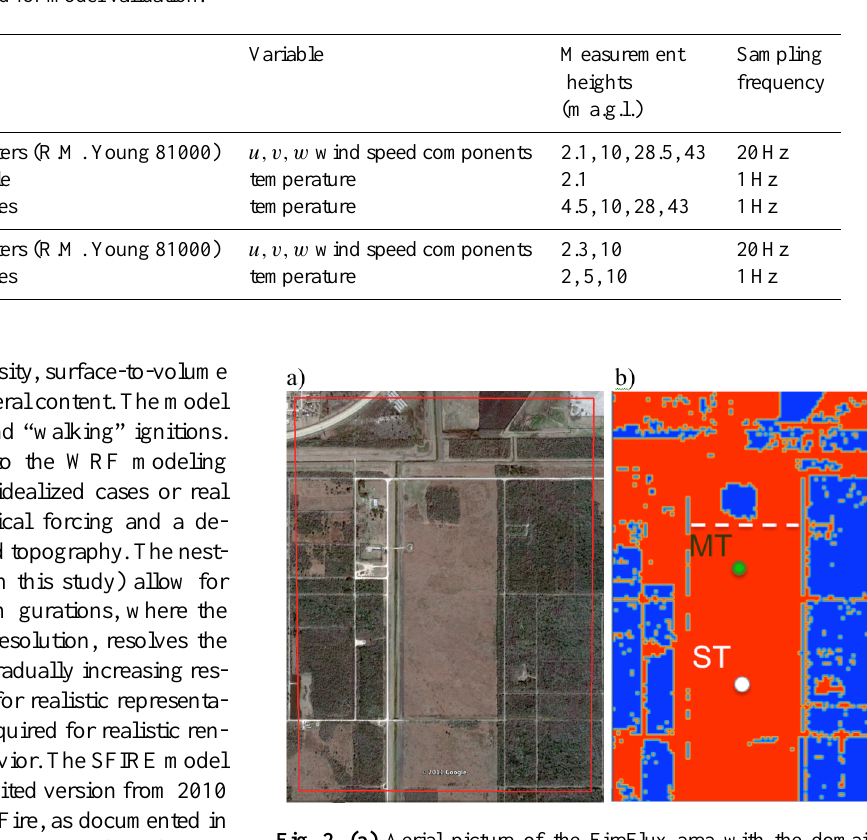
Table 1. Summary of instrumentation used for model validation.